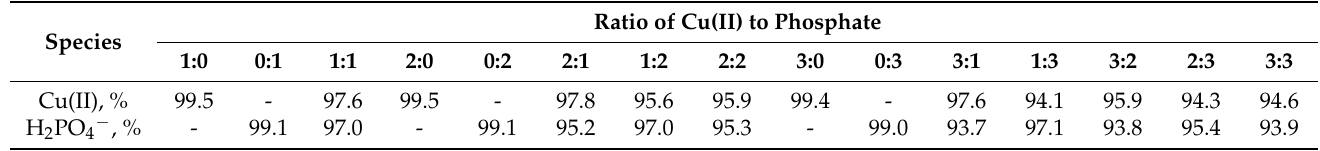
Table 1. The portion of Cu(II) and H 2 PO 4 − species at the different initial concentrations using Visual MINTEQ 3.1.